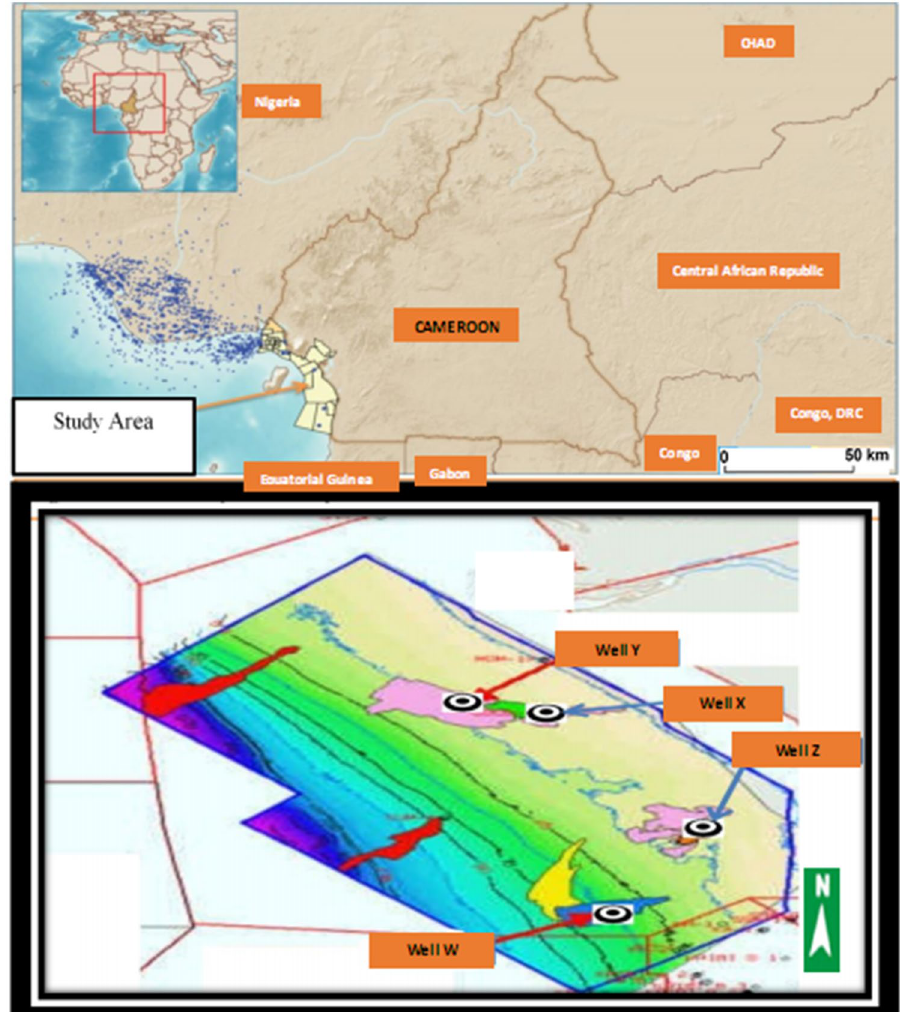
Fig. 1 Location map of the “M-Field”, Douala Basin, Cameroon adopted from SPT 1995 showing the various well